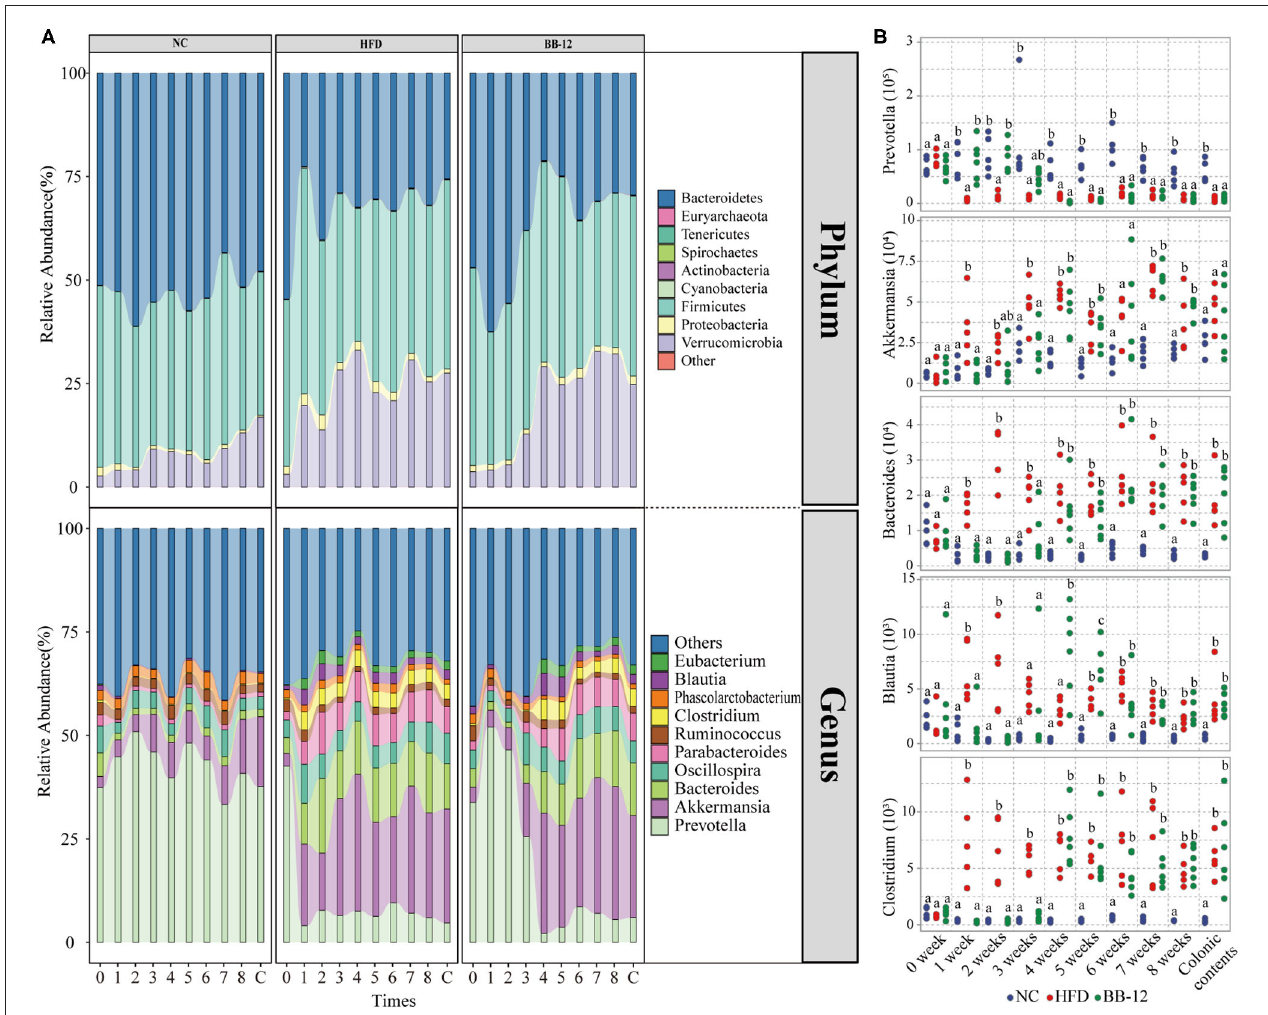
FIGURE 2 | Gut microbiota taxonomic profiles. (A) Relative abundances of microbial composition at the phylum level and relative abundances of top 10 genera; 0–8 represents 0–8 weeks and C represents colonic content samples. (B) Absolute abundances of microbial taxa (genera level) compared between the NC, HFD, and BB-12 groups. Different letters (a or b) above the box indicate significant difference ( p < 0.05) or ( p <